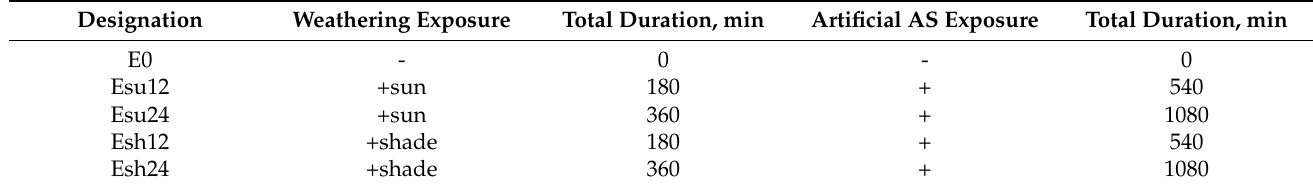
Table 2. Overview of the aging